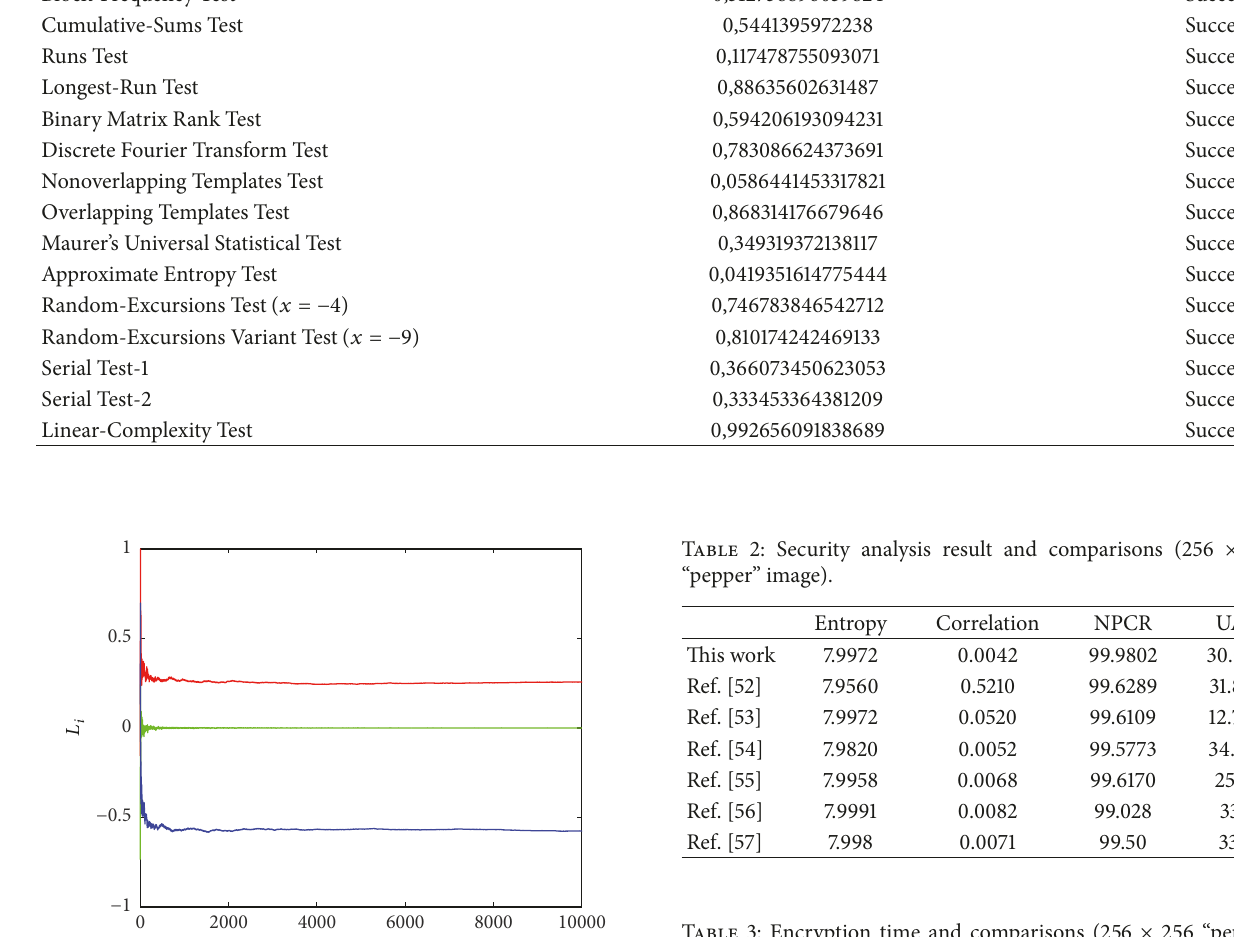
Table 3: Encryption time and comparisons ( 256 × 256 “pepper” 𝐿 𝐿 1 (red), 2 (green), and 3 (blue).